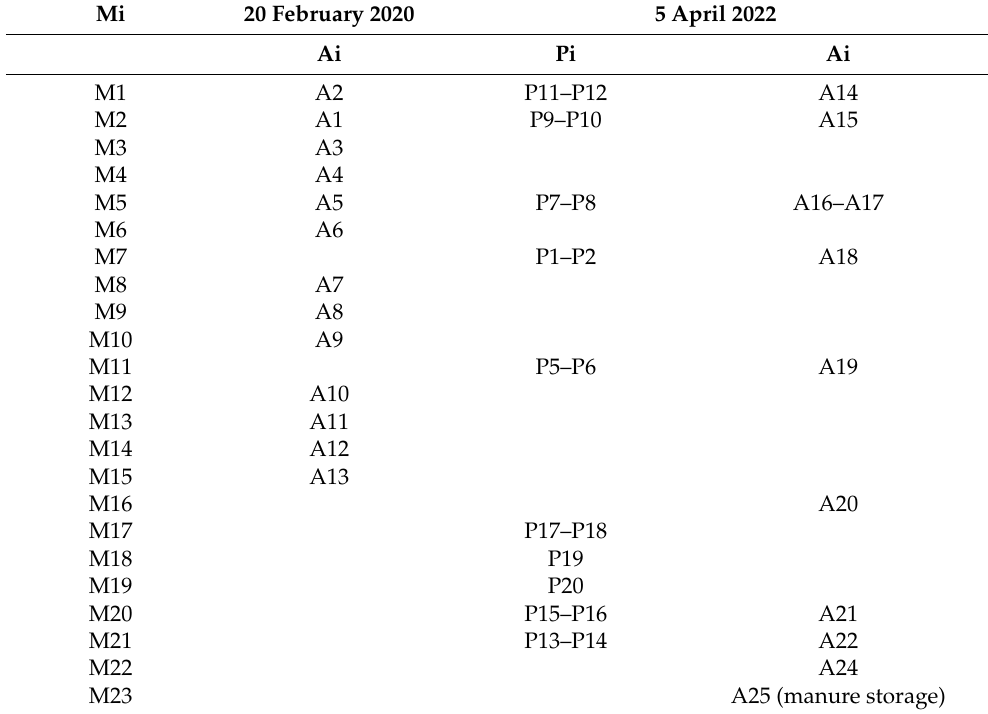
Table 1. Correspondence between sampling points (Mi) and passive (Pi) and active (Ai) measurements of the samplings of days 20 February 2020 and 5 April